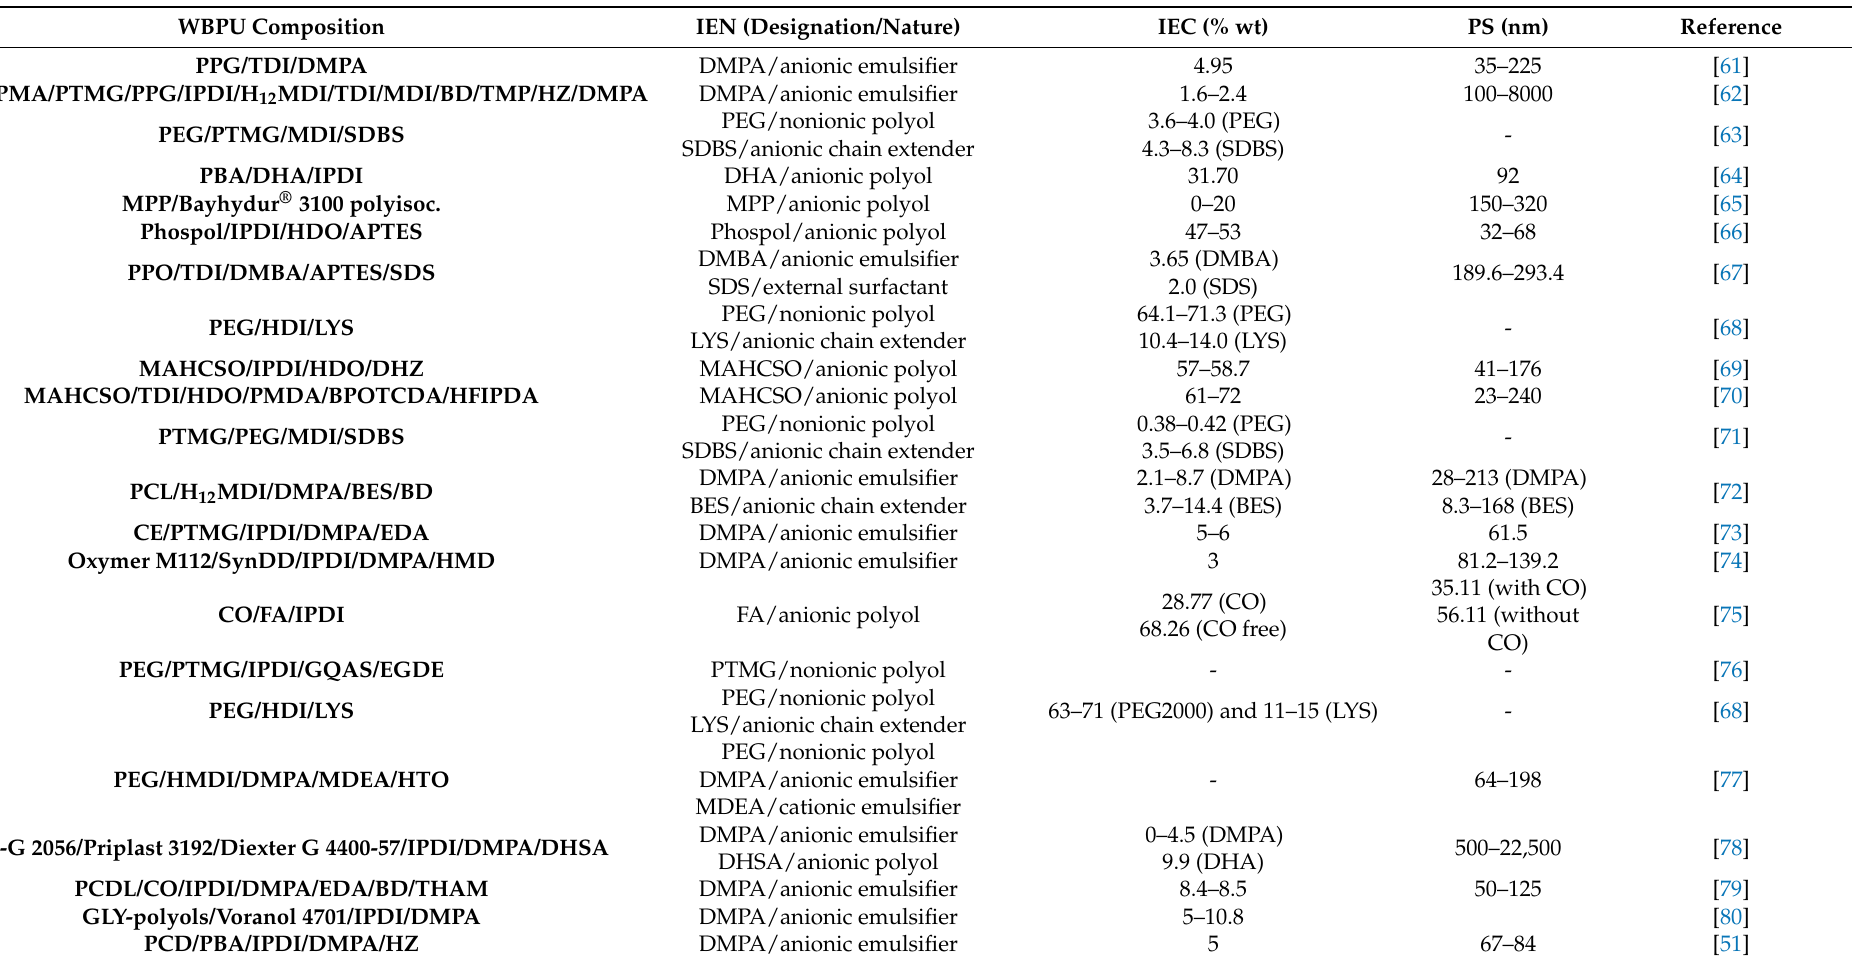
Table 2. Summary of gathered examples of WBPU and WBPUU prepared from conventional and alternative emulsifiers highlighting the chemical composition (WBPU composition), internal emulsifier nature (IEN), internal emulsifier content (IEC), and particle average size